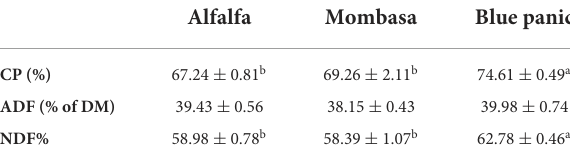
TABLE 3 Digestibility of crude protein, acid detergent fiber, and neutral detergent fiber in growing goats fed alfalfa, Mombasa, or blue panic.